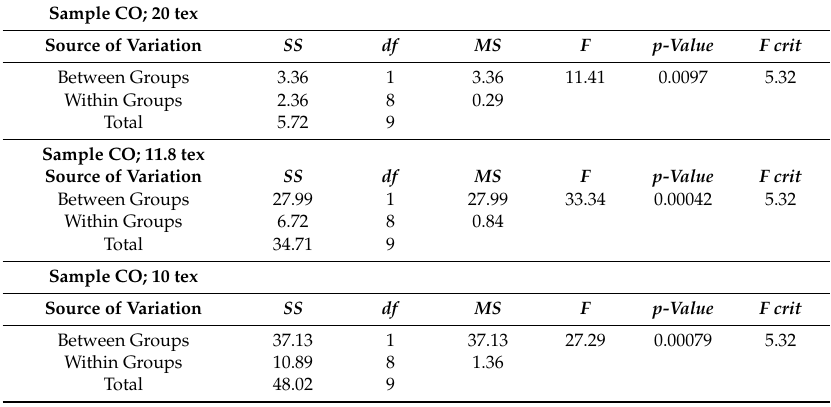
Table 9. The results of the statistical analysis of the influence of yarn twist on tenacity.